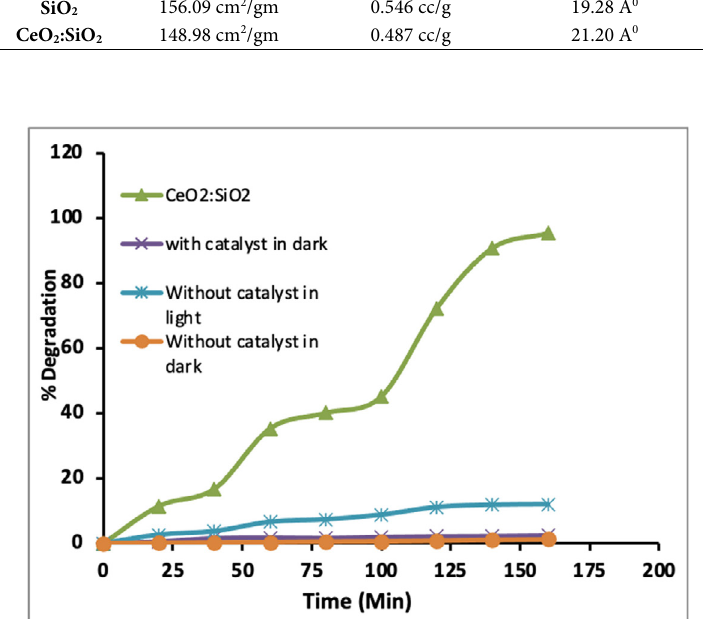
Fig. 7. Effect of catalyst and light irradiation on dye industrial wastewater